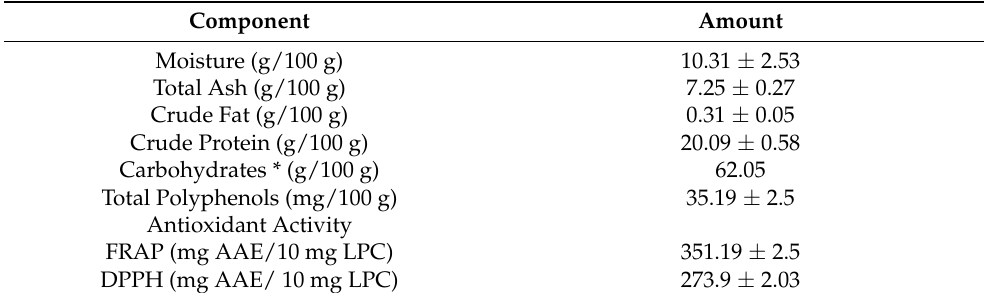
Table 1. Chemical composition and antioxidant capacity of the lupin protein concentrate (LPC). Data are expressed as the mean ±